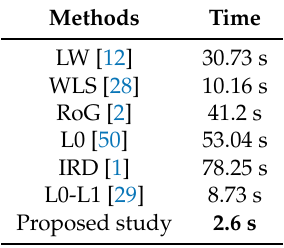
Table 3. Time analysis between the compared methods.